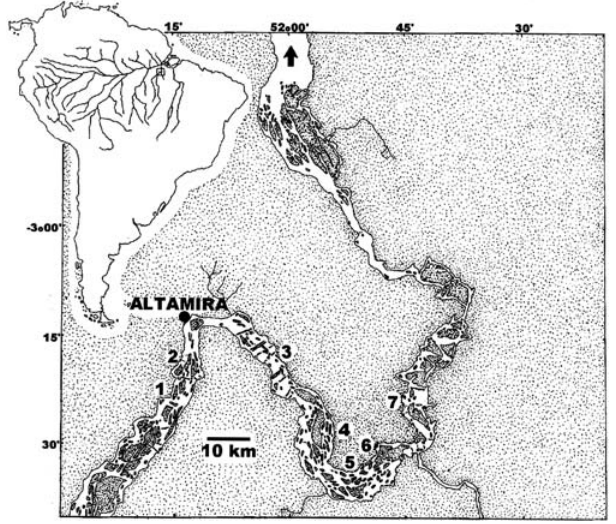
Description . Body proportions and meristics in Table 1. Head